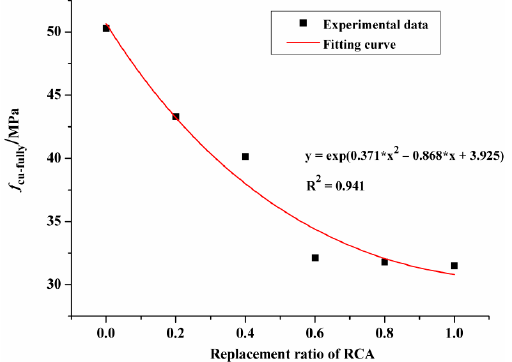
Figure 6. The f cu-fully versus the replacement ratio of RCA.